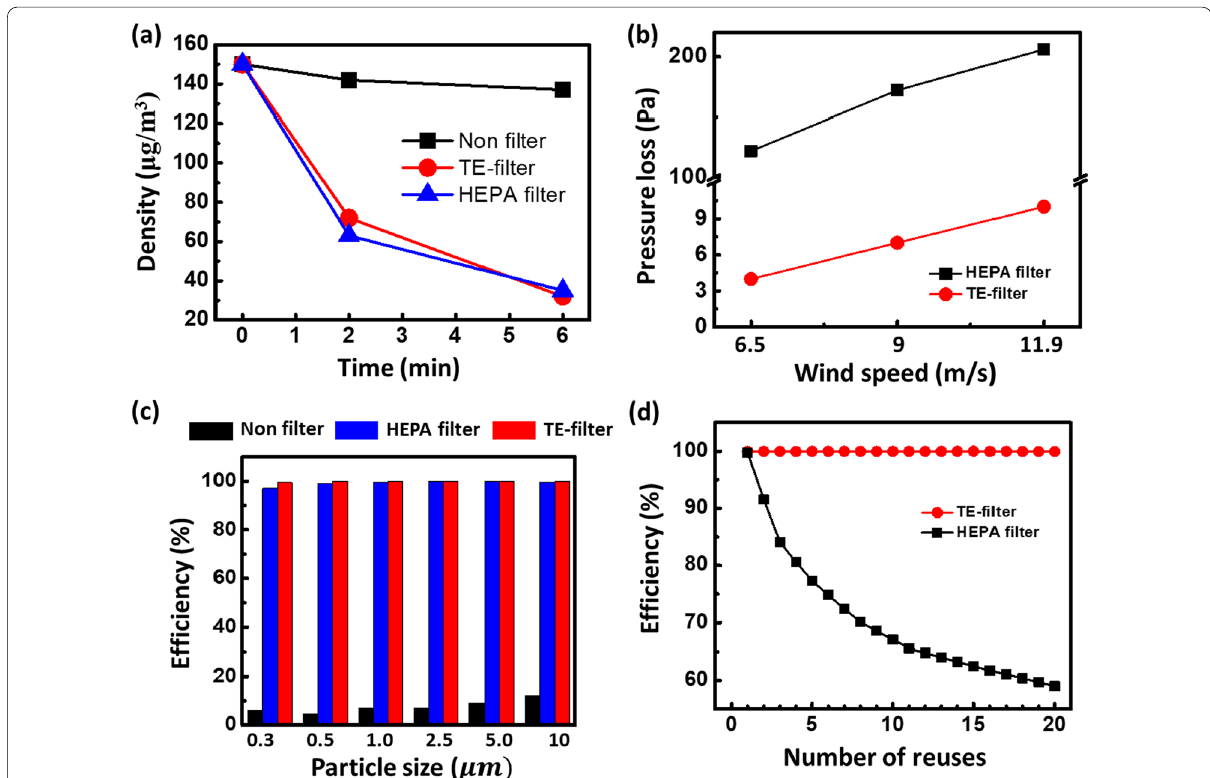
Fig. 6 Performance characterization of TE filter. a Performance comparison, in terms of the density of the particles in the filtered air, of the proposed filter with the commercial HEPA filter and with the case of no filter. b Comparison of the pressure loss due to the presence of the TE filter with that of the HEPA filter. c Dust collection efficiency as a function of the particle size for the proposed TE filter, HEPA filter, and the case of no filter. d Change in dust collection efficiency after washing for both HEPA filter and TE